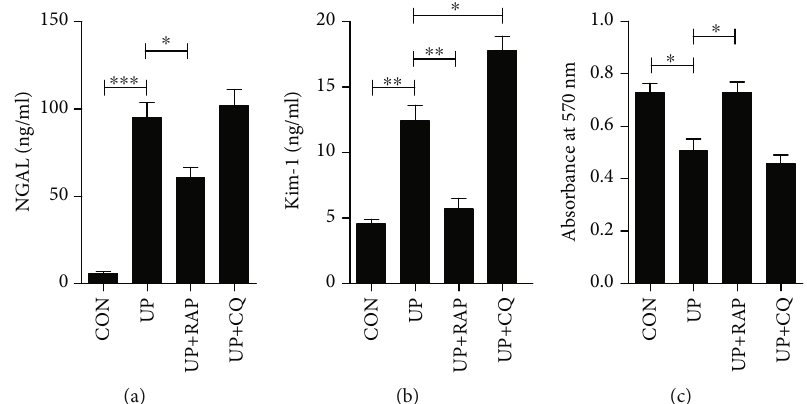
Figure 4: E ff ects of rapamycin or chloroquine on damage to TECs induced by urinary protein. (a, b) The levels of supernatant NGAL and KIM-1 were measured by ELISA after exposure to vehicle, urinary proteins (UP, 8 mg/ml), UP (8 mg/ml) plus rapamycin (RAP, 10 μ M), or UP (8 mg/ml) plus chloroquine (CQ, 10 μ M). (c) Cell proliferation was assessed by MTT assay as described in (a). ∗ P < 0 : 05 , ∗∗ P < 0 : 01 . CON: control; UP: urinary proteins; RAP: rapamycin; CQ: chloroquine.